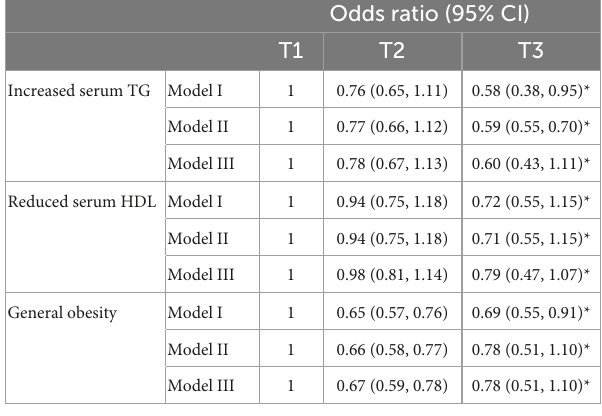
TABLE 4 The multivariate-adjusted means for HDL and TG according to tertiles (T) of the MIND diet score. Odds ratio (95%